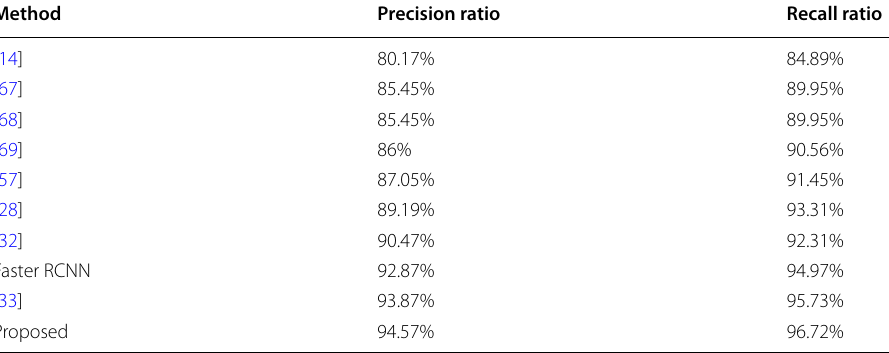
Table 7 Comparison with existing methods